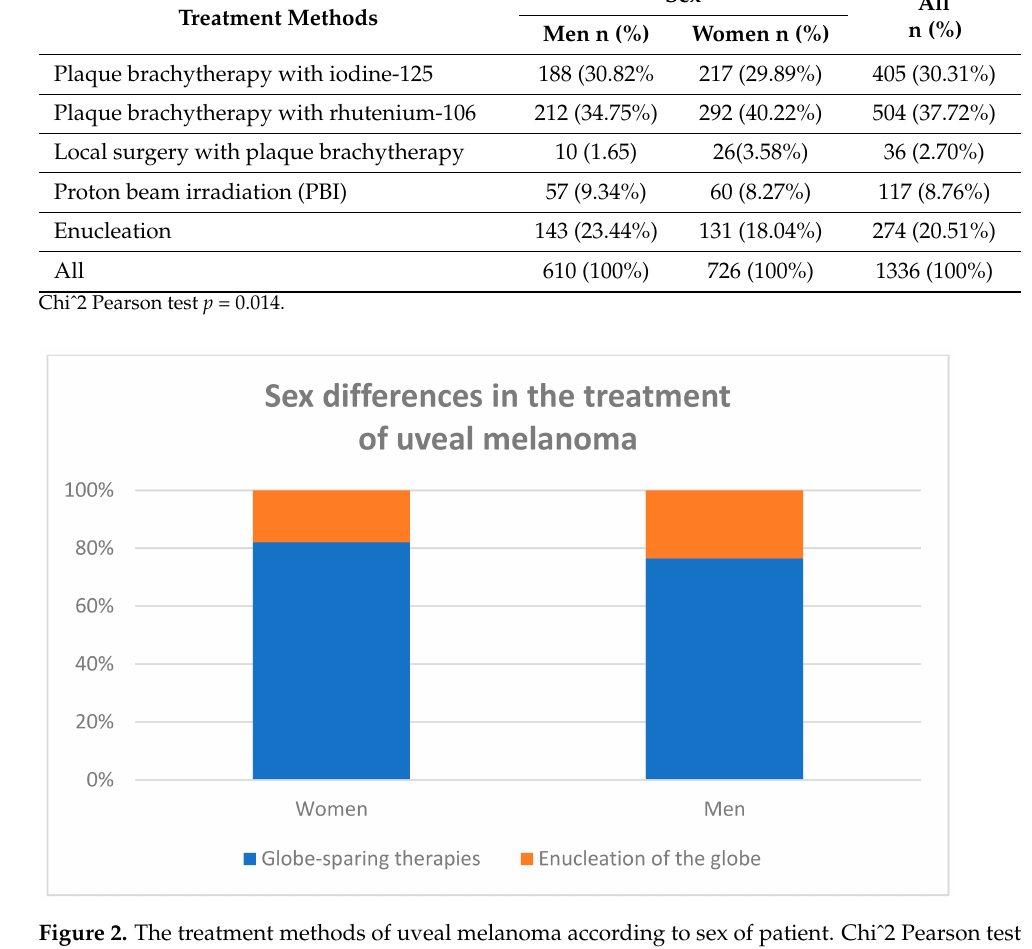
Figure 2. The treatment methods of uveal melanoma according to sex of patient. Chiˆ2 Pearson test p = 0.015.